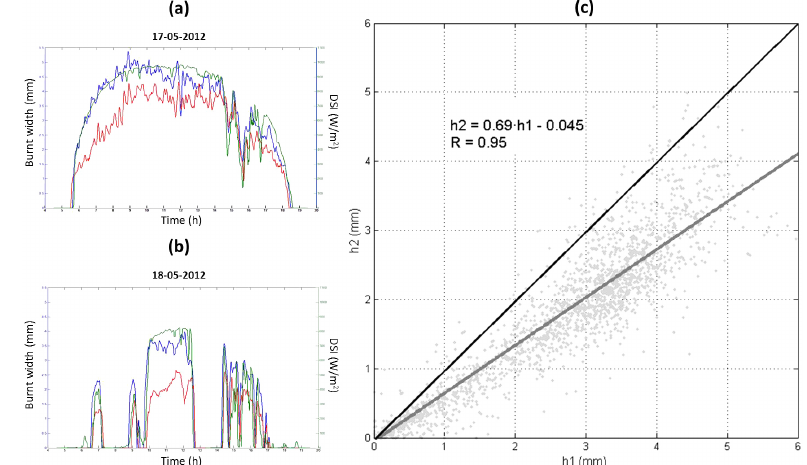
Figure 5. (a, b) Daily evolution of burn width (blue line for CSSR1 and red line for CSSR2) and DSI (green line) for 2 different days. (c) Scatter plot of the burn width in CSSR2 ( h 2 ) versus that of CSSR1 ( h 1 ) on hourly resolution. We also represent the 1:1 line (black line) and the linear regression fit (green